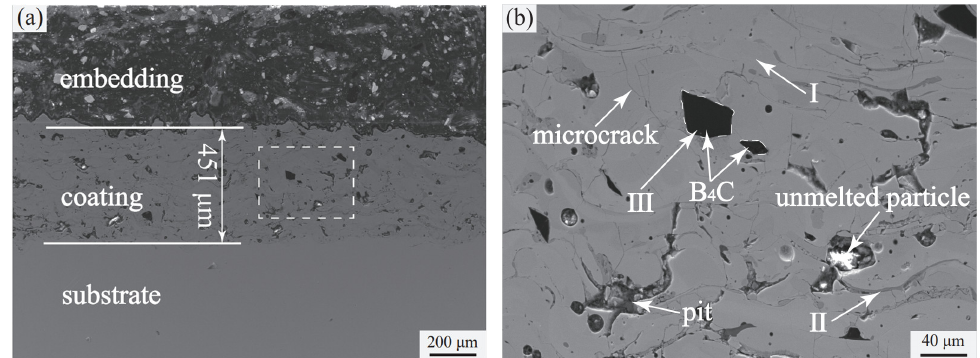
Figure 4. Cross-sectional morphology of coating ( a ) at 200×; ( b ) at 1000× . Table 8. The results of EDS in different areas (wt. %).